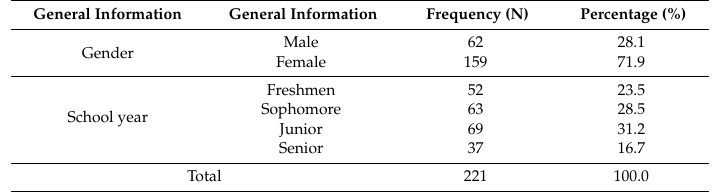
Table 2. General characteristics of the subject.